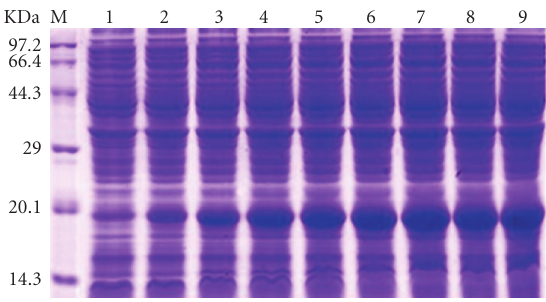
Figure 1: SDS-PAGE analysis of recombinant IL-33 protein expressed by E. coli . The expression was induced by 1 mM IPTG at 25 ◦ C for di ff erent periods. Lane M: protein molecular weight marker; lanes 1–9: whole cell lysates after 1, 2, 3, 4, 5, 6, 7, 8, and 9hours IPTG induction at 25 ◦ C, respectively.